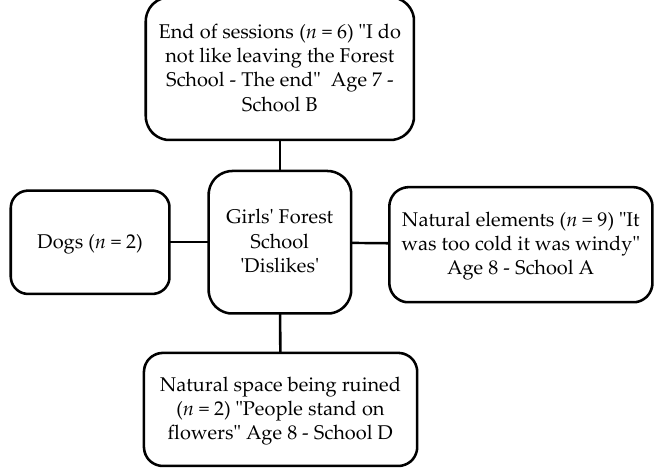
Figure 8. Pen profiles for boys’ answers to “What I dislike about Forest School is…?”. Children 2018 , 5 , x FOR PEER REVIEW